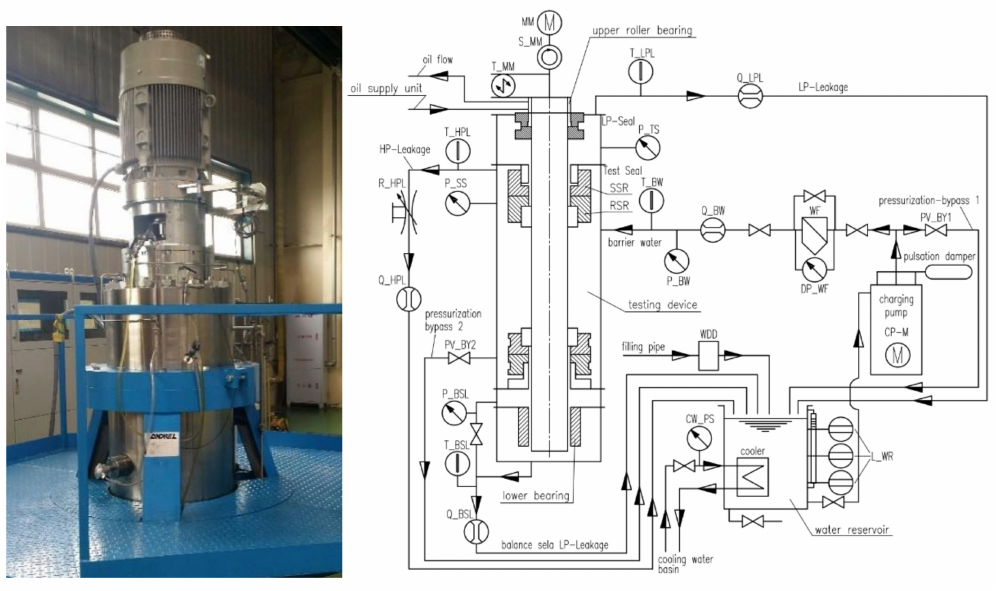
Figure 6. Test rig.